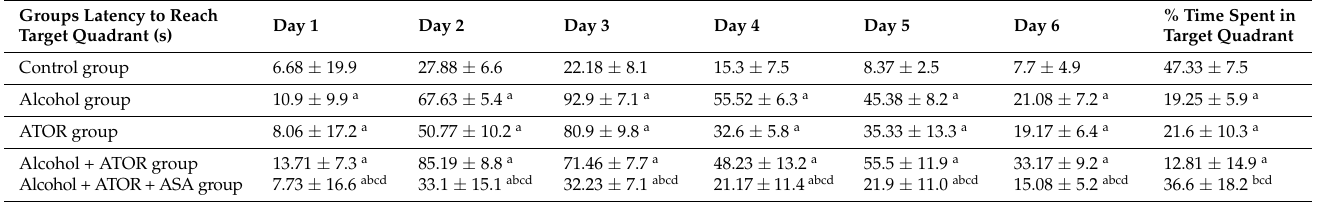
Table 1. Assessment of cognitive function in the different treated groups by the Morris water maze (MWM) test (mean ±